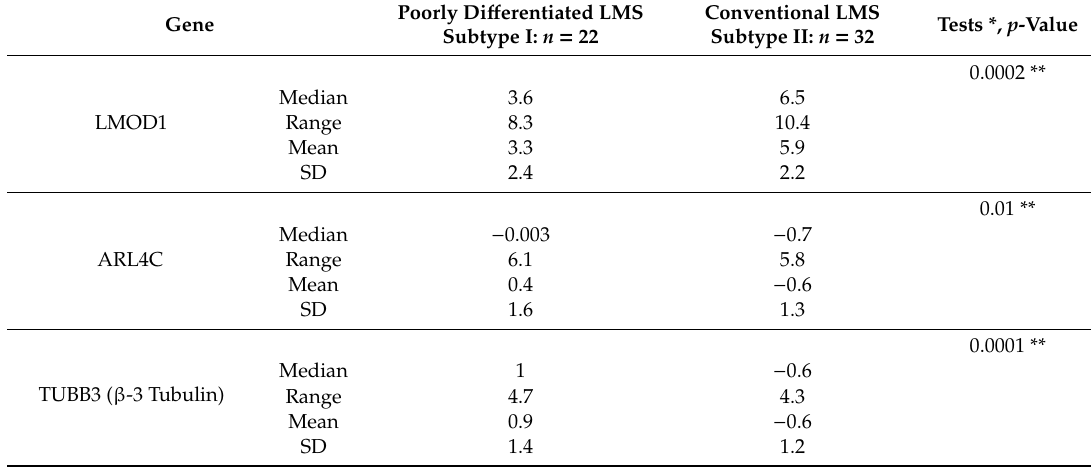
Figure 2. Gene expression analysis of leiomyosarcoma (LMS) from the TCGA. ( A ) Gene expression heat map for LMOD1, ARL4C, TUBB3, and PTGER4 from conventional (dark blue) or poorly differentiated (light blue) leiomyosarcoma obtained from the cancer genome atlas (TCGA). Red indicates higher gene expression and green lower gene expression. Samples were restricted to female patients with LMS from gynecologic and retroperitoneal areas ( n = 54). LMOD1 and ARL4C are biomarkers for conventional and poorly differentiated subtypes, respectively. ( B ) Mean gene expression for LMOD1, ARL4C, TUBB3, and PTGER4 segregated by LMS subtype. Gene expression for conventional LMS indicated in blue and for poorly differentiated LMS in red. Heat map image was modified from the Xena Browser [31]. Table 1. TCGA Gene Expression Analysis.